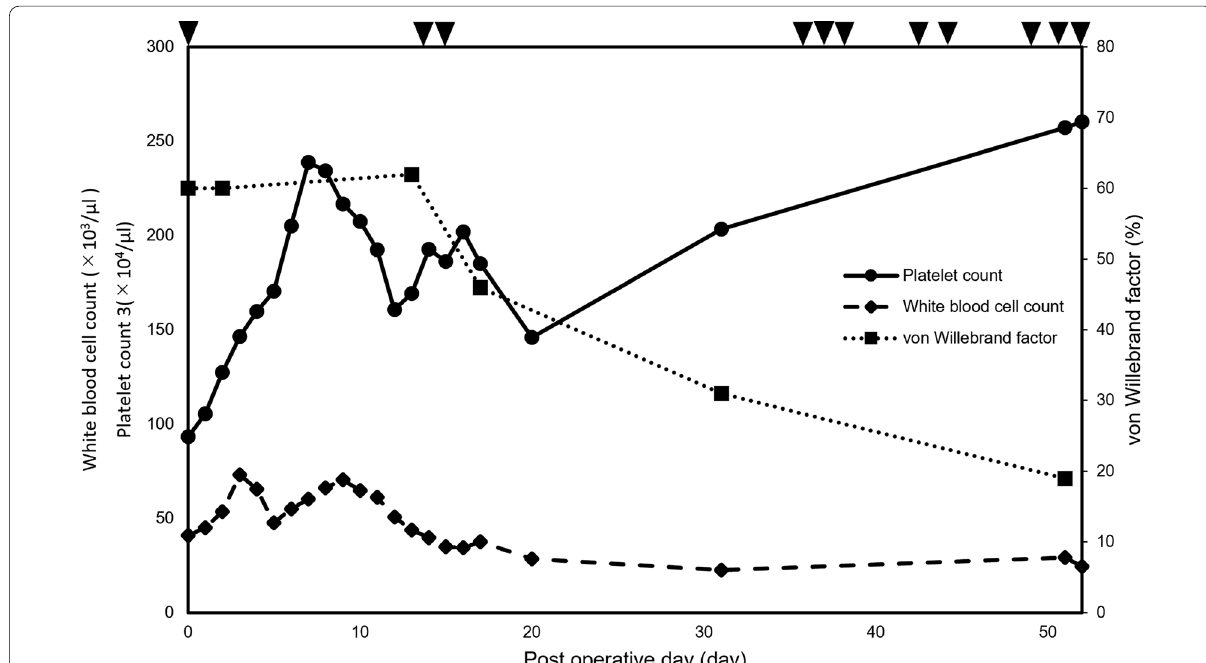
Fig. 5 Postoperative white blood cell count, platelet count, and von Willebrand factor level. Postoperatively, platelet count gradually increased and von Willebrand factor decreased. With a decrease in von Willebrand factor, the patient repeatedly suffered from bleeding events (arrowhead). White blood cell count increased in the perioperative period and gradually decreased